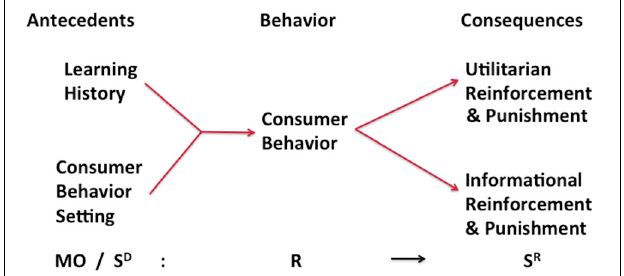
FIGURE 1 | The behavioral perspective model of consumer choice. Adapted from Foxall (1990/2004). Used by permission.